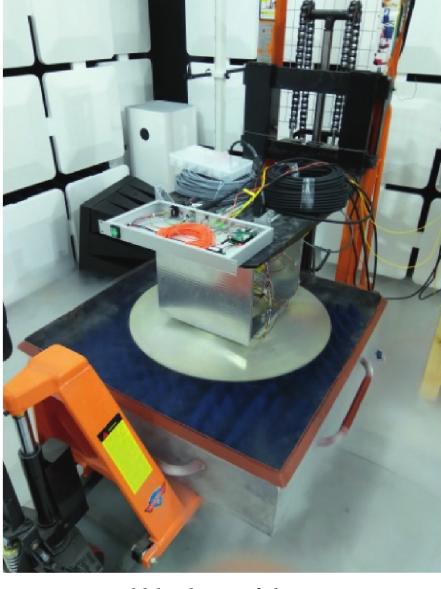
Figure 4: Cold load test of the UWB